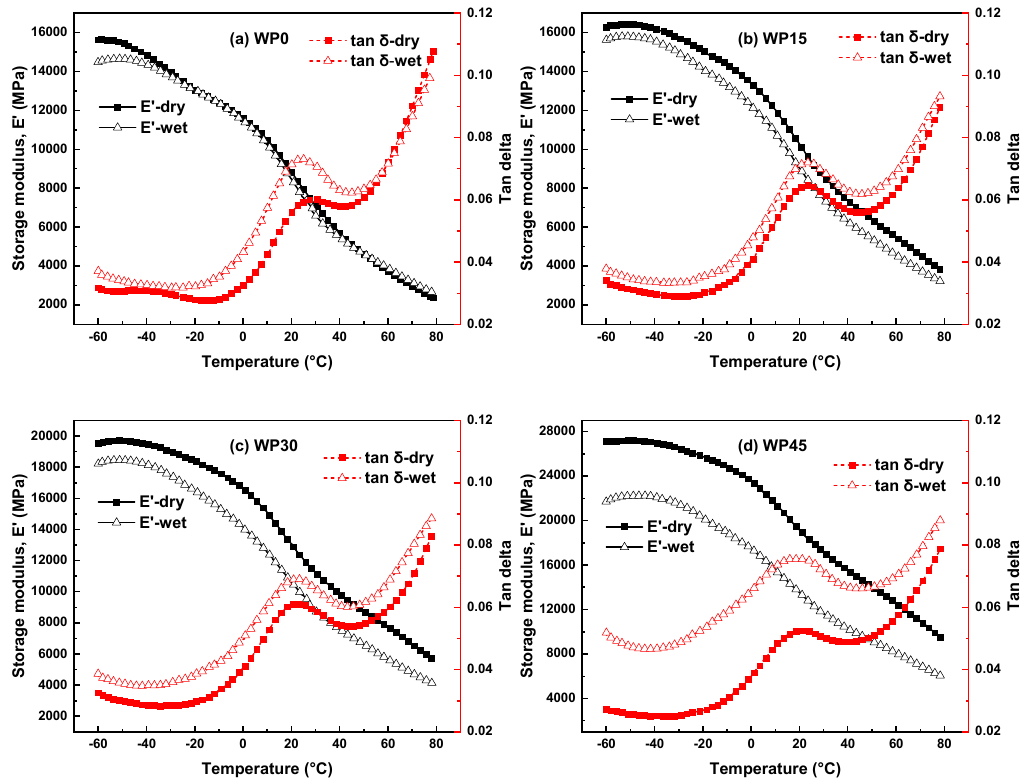
Figure 7. The storage modulus and loss factor of the specimens immersed in distilled water and corresponding dry specimens: ( a ) WP0, ( b ) WP15, ( c ) WP30 and ( d ) WP45.